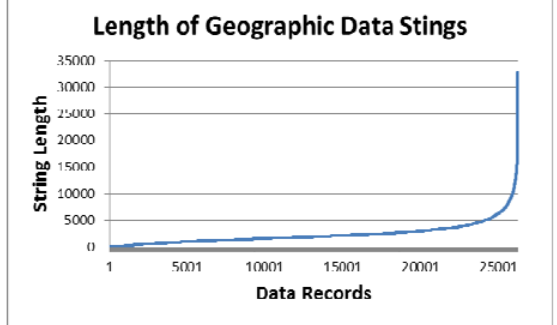
Figure 2. Length of Geographic Data